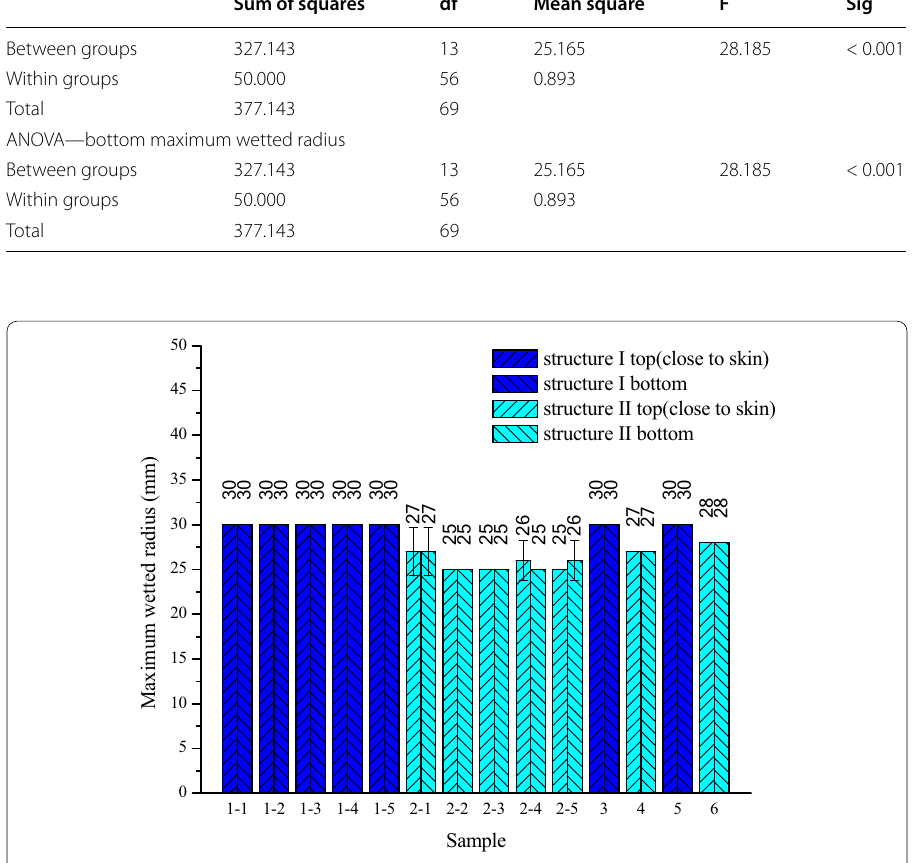
Fig. 3 The results of maximum wetted radius by MMT